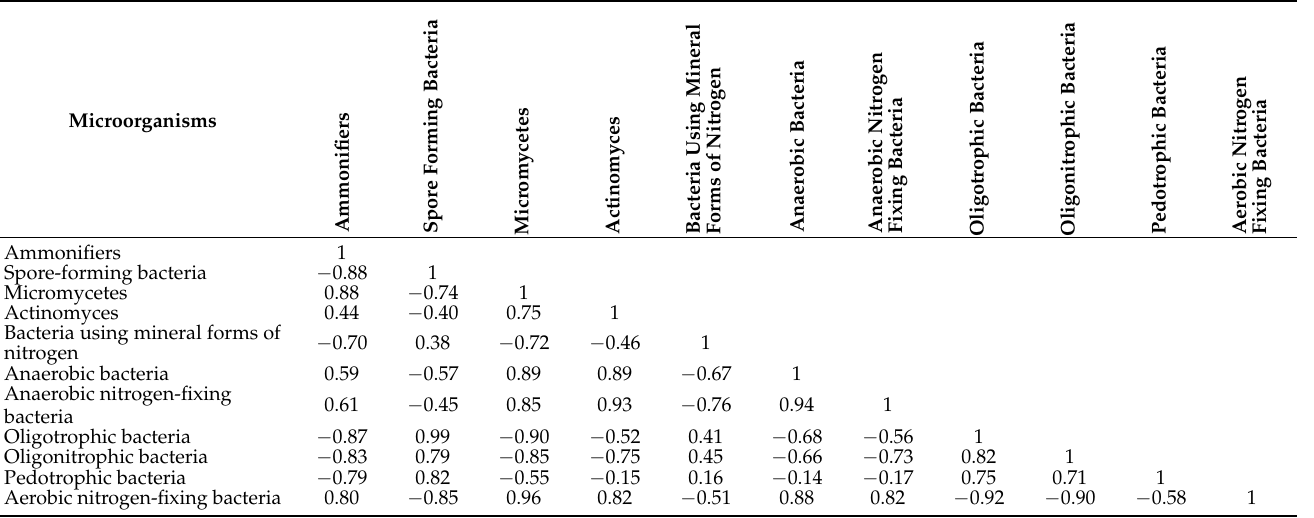
Table 2. The integrity of the soil microbial community in edaphotopes of agroecosystem contaminated by an